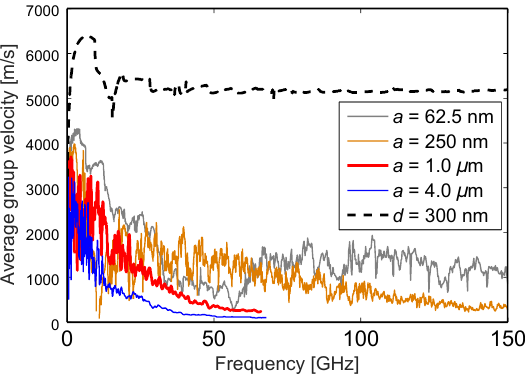
Figure 6. Average group velocity of a full membrane and four PnC membranes with the same thickness and different lattice constants. The PnC curves are smoothed for visual